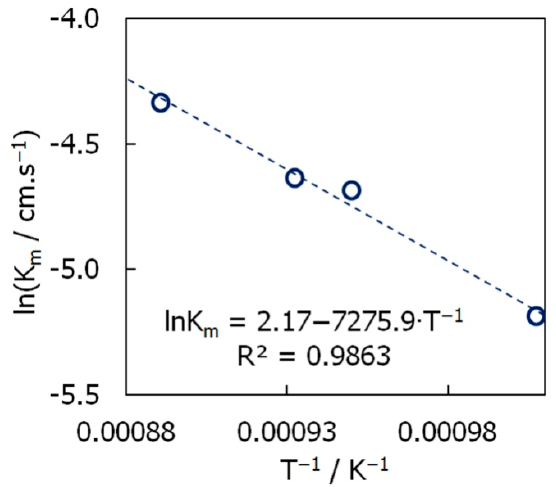
Figure 4. The change in the logarithm of the apparent mass transport coefficient vs. the inversed temperature.